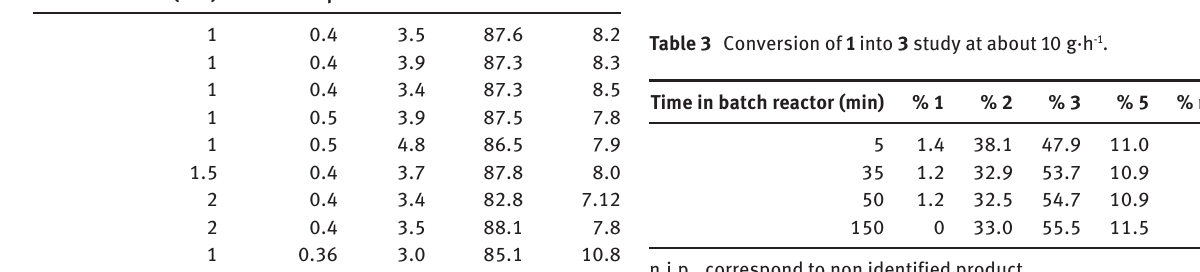
Table 2 Study of the conversion of 1 into 2 at about 10 g · h -1 . Residence time (min)